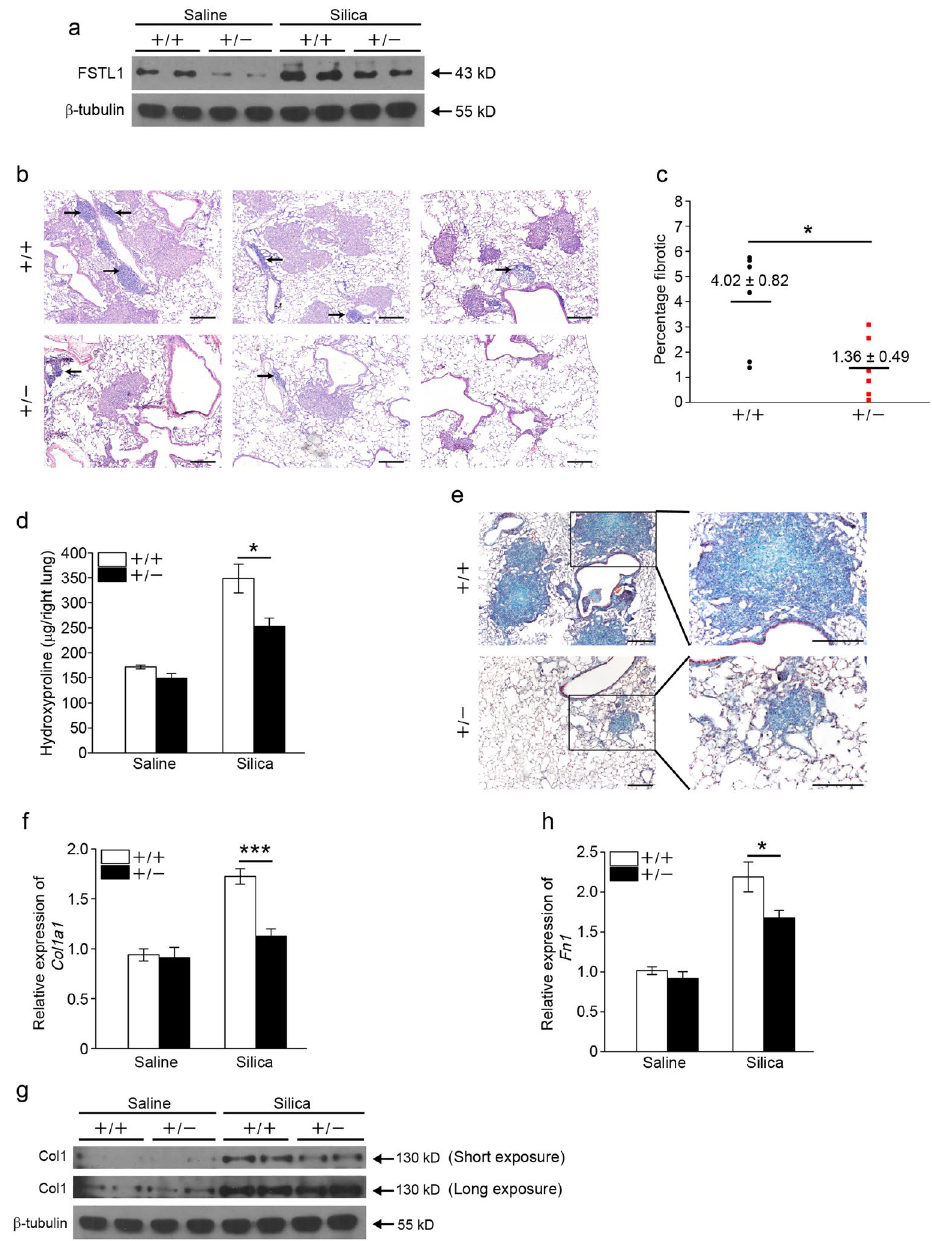
Figure 2. Fstl1 + / − mice have an attenuated pulmonary fibrosis phenotype. ( a ) Western blot analysis of FSTL1 expression in lung tissues of Fstl1 + / − and WT mice 21 days after saline or silica injury. β -tubulin was used as a loading control. ( b ) H&E staining of lung sections of Fstl1 + / − and WT mice 21 days after silica injury. Representative images of the staining are shown. Arrows show inflammatory cells. (n = 6 per group; scale bars, 200 μ m). ( c ) Lung fibrotic score analysis of the lung sections from Fstl1 + / − and WT mice 21 days after silica injury (n = 6 per group; * P < 0.05 by one-way ANOVA followed by Student’s t test). The fibrotic area is presented as a percentage. ( d ) Hydroxyproline contents in lung tissues from Fstl1 + / − and WT mice were measured 21 days after saline or silica injury (n = 6 per group; * P < 0.05 by one-way ANOVA followed by Student’s t test). ( e ) Masson trichrome staining of lung sections of Fstl1 + / − and WT mice 21 days after silica treatment. Representative images of the staining are shown (n = 6 per group; scale bars, 200 μ m). ( f ) qRT- PCR analysis of Col1a1 mRNA expression in lung tissues from Fstl1 + / − and WT mice 21 days after saline or silica injury (n = 3 per group; *** P < 0.001 by one-way ANOVA followed by Student’s t test). ( g ) Western blot analysis of type I collagen (Col1) expression in lung tissues from Fstl1 + / − and WT mice 21 days after saline or silica injury (n = 3 per group). β -tubulin was used as a loading control. ( h ) qRT-PCR analysis of fibronectin ( Fn1 ) mRNA expression in lung tissues from Fstl1 + / − and WT mice 21 days after saline or silica injury (n = 3 per group; * P < 0.05 by one-way ANOVA followed by Student’s t